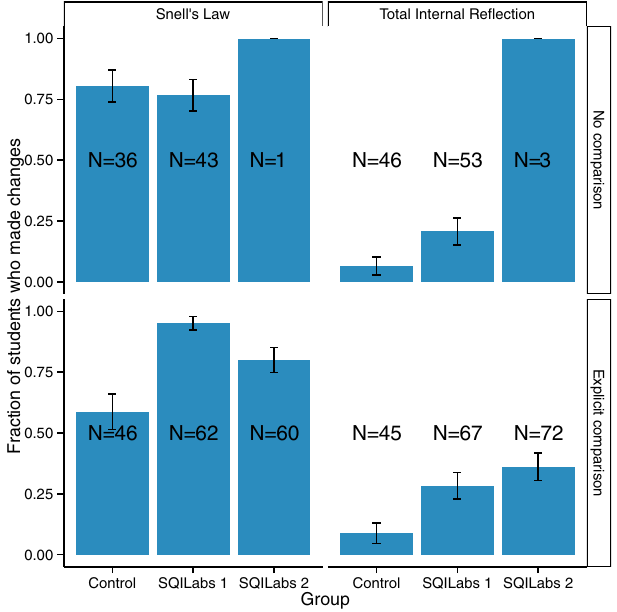
FIG. 4. The fraction of students who made changes to each of their measurements, including only students who had initially inaccurate measurements, and separated by whether they made explicit comparisons between their measurements. The N labels are the number of students who did or did not make comparisons in each corresponding bin, so the height of the bars represent the number students who made changes as a fraction of those who did (bottom row) or did not (top row) make comparisons and had initially inaccurate